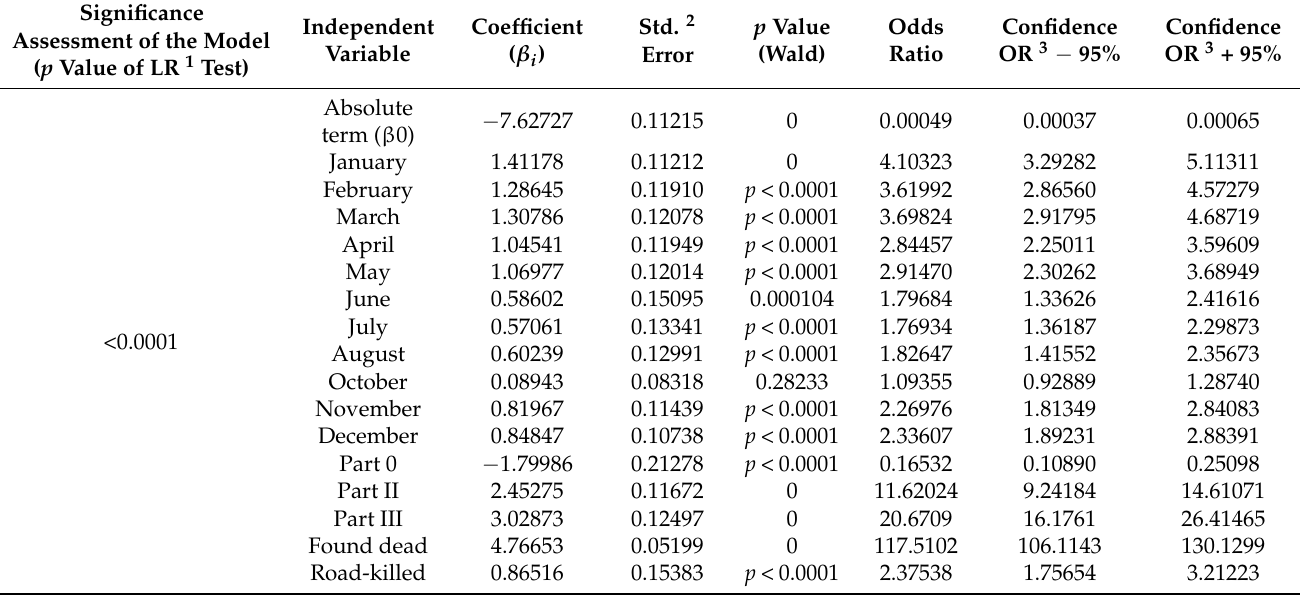
Table 6. Results of logistic regression models. Comprehensive